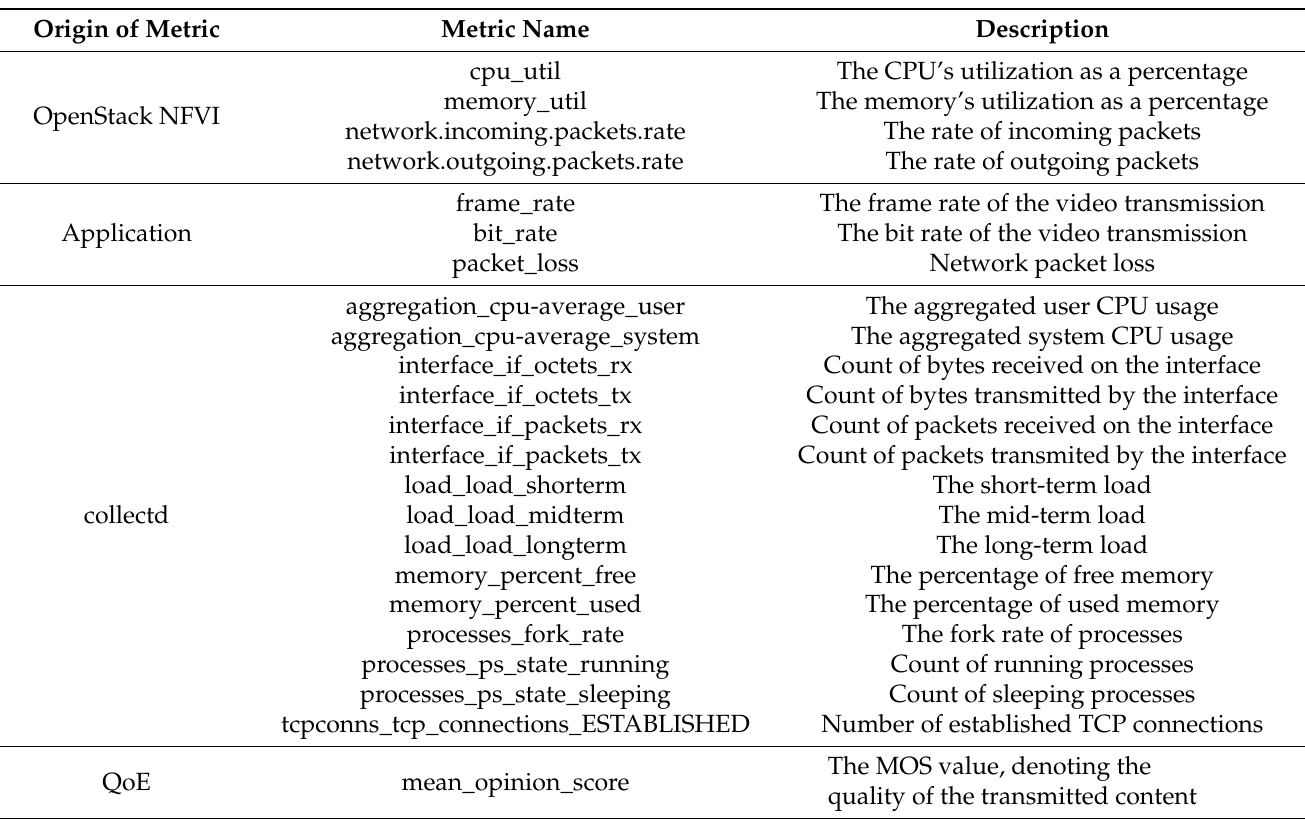
Table 2. Employed monitoring